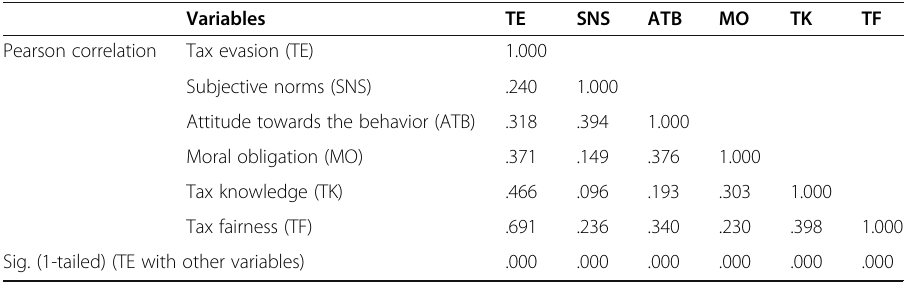
Tax fairness (TF) Sig. (1-tailed) (TE with other variables) .000